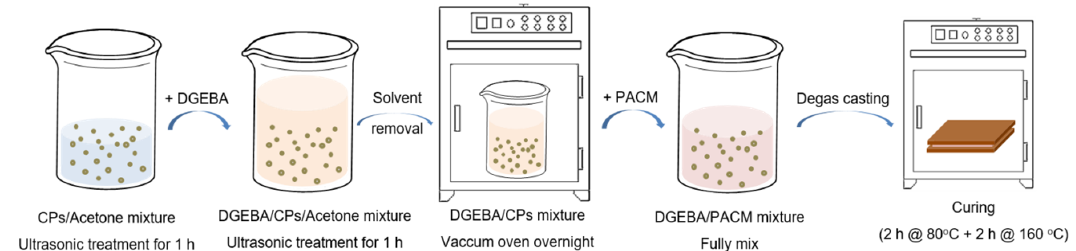
Figure 2. Schematic preparation procedure of SiO 2 @IL CPs / epoxy-amine networks.